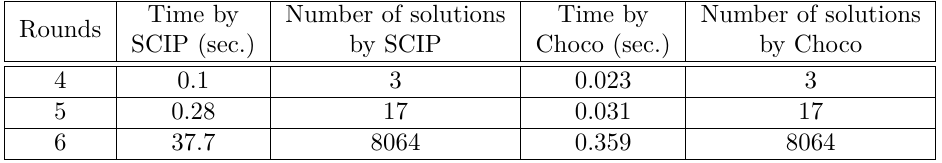
Table 4: Efficiency comparison of SCIP and Choco in enumerating characteristics in the linear hulls of